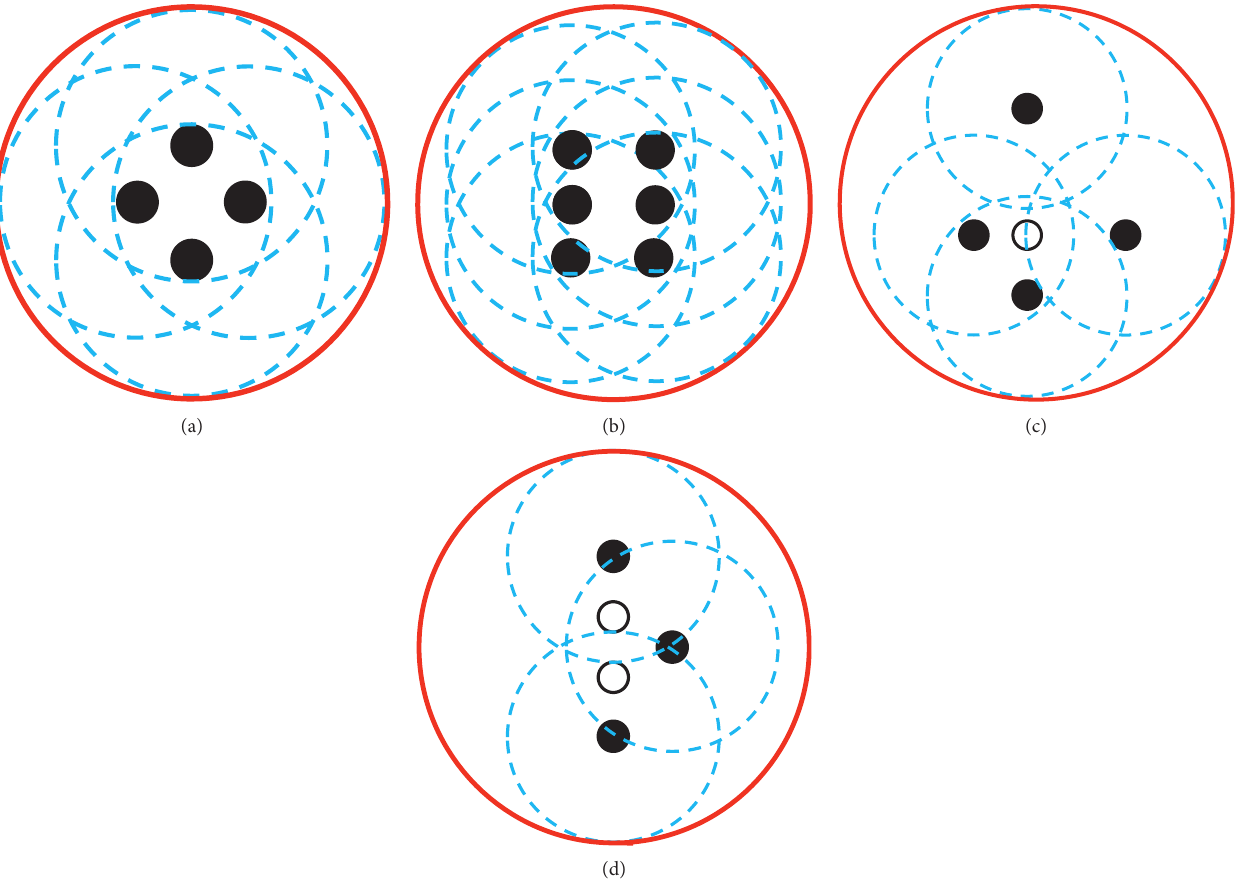
Figure 2: Equivalent elastic boundary diagrams of several typical cut hole arrangements. (a) Conical cut holes. (b) Wedge cut holes. (c) Spiral cut holes. (d) Bucket cut